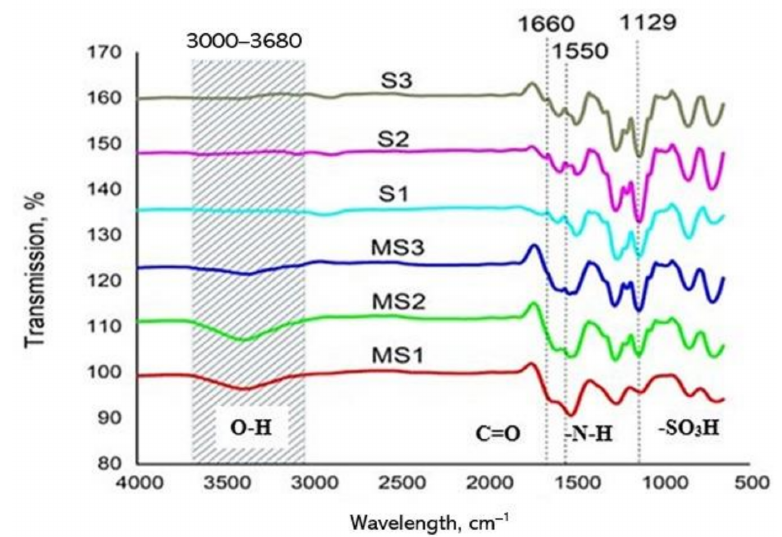
Figure 4. Attenuated total reflection–Fourier transform infrared spectroscopy (ATR–FTIR) Spectra of the synthesized TFC FO membranes.